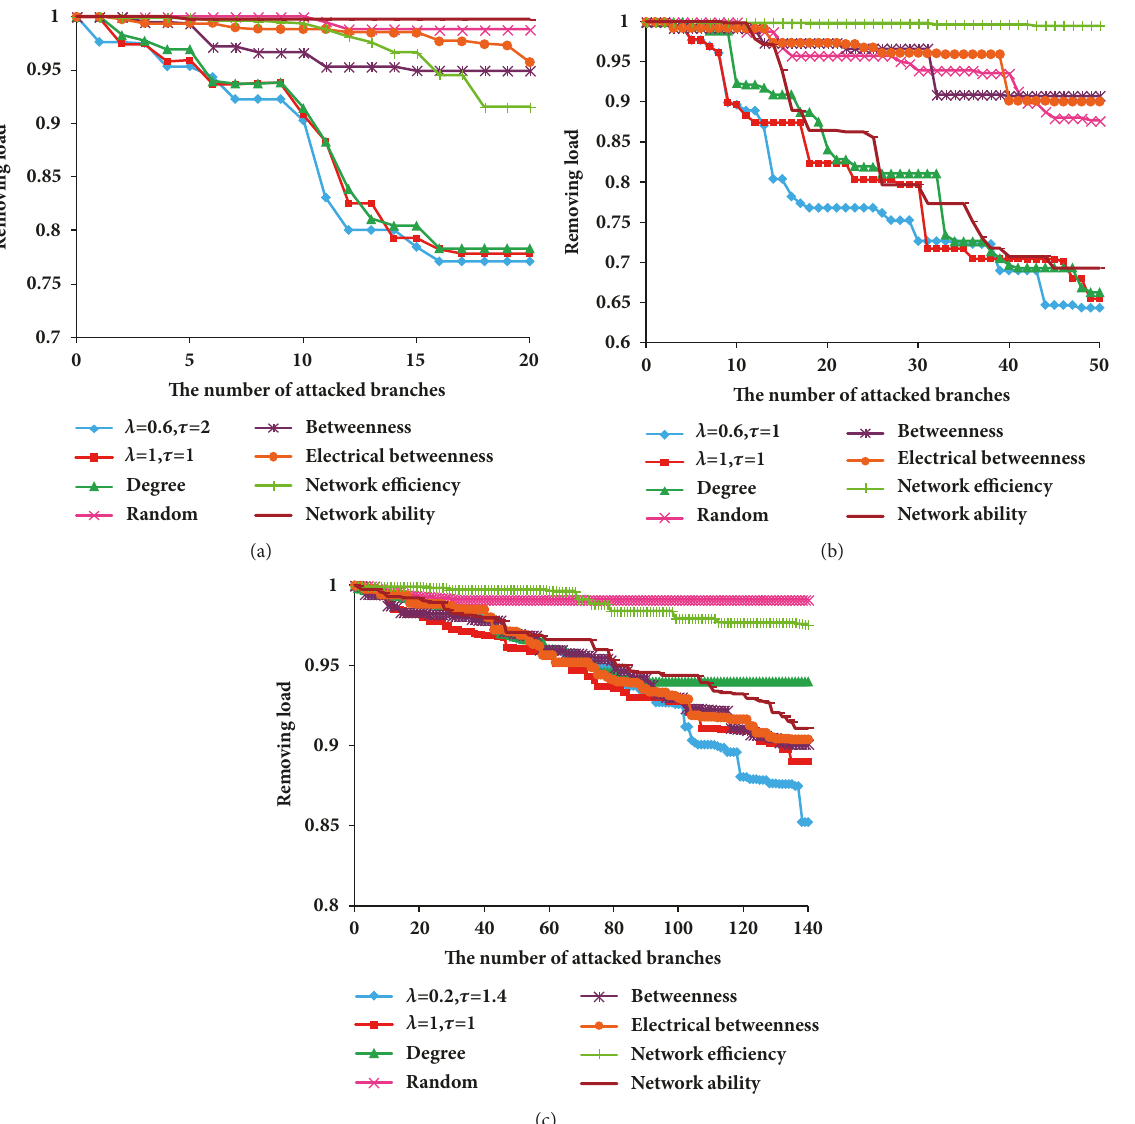
Figure 11: The remaining load with the number of the critical branches increasing. (a) IEEE 118-bus system; (b) IEEE 300-bus system; (c) French